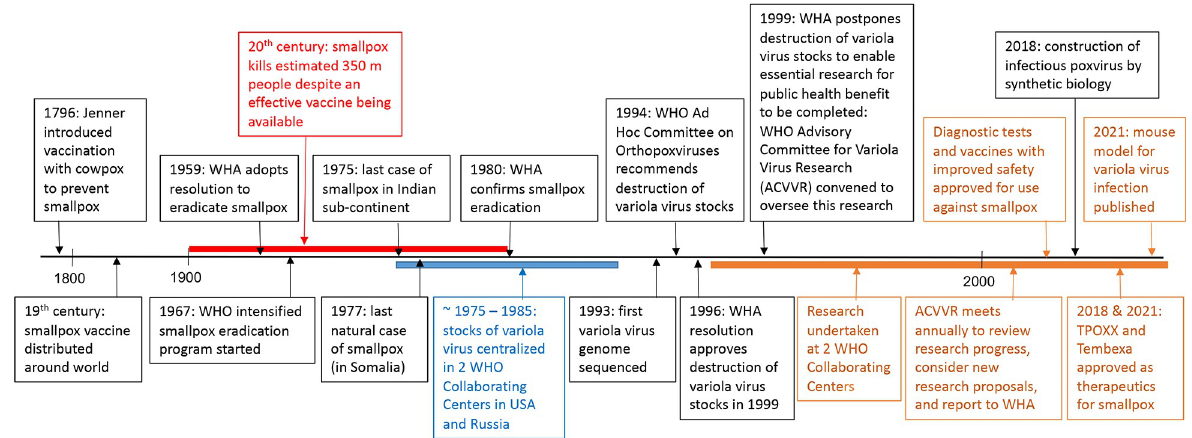
Fig 1. Timeline of significant